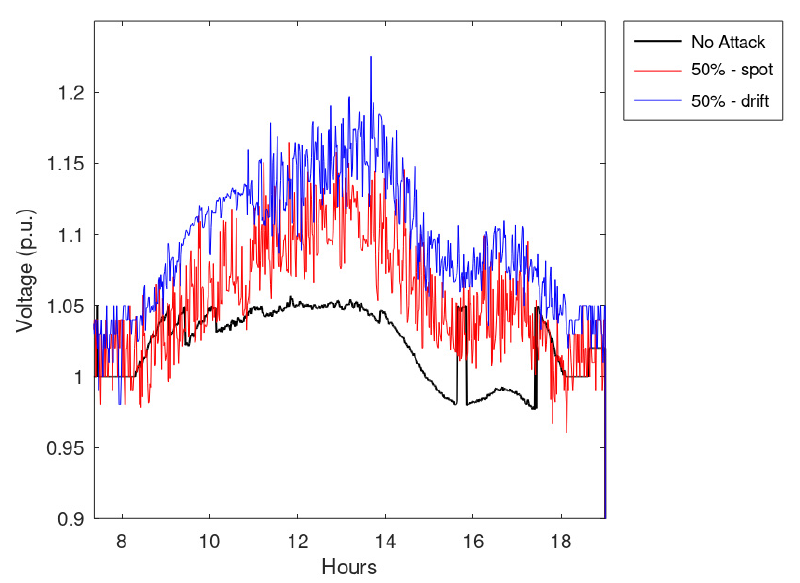
Figure 13. Maximum network voltage during the timestamps considering half of the measurements falsified.